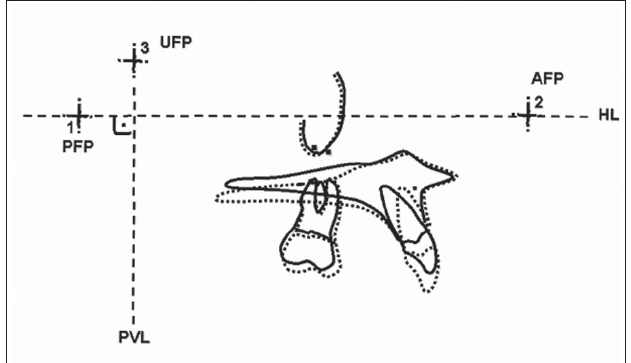
Fig. 1 . Partial superimposition on the maxilla, transference of the three fiducial points (1, Posterior Fiducial Point-PFP; 2, Anterior Fiducial Point-AFP; 3- Upper Fiducial Point-UFP), and construction of HL(Horizontal Line) and PVL(Posterior Vertical Line).